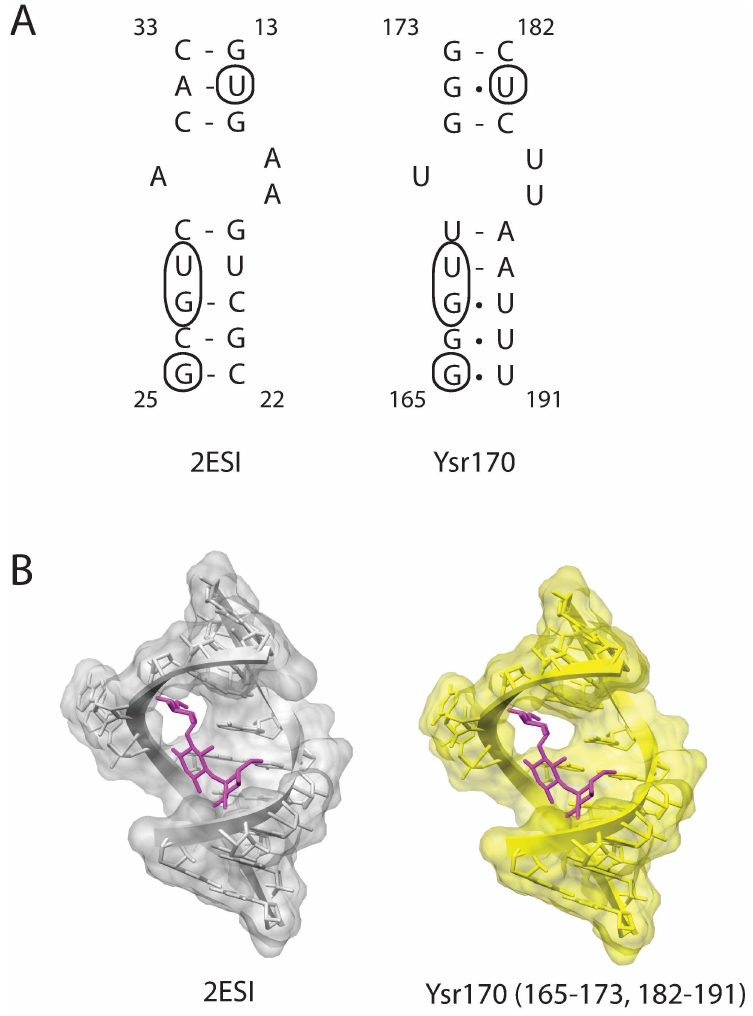
Fig 7. Structural modeling of Ysr170 binding to gentamycin. (A) The Ysr170 nucleotide regionthat binds to gentamycin, as determined by SHAPE analysis, is comparedto the sequenceof a structurally homologous regionfrom 16S rRNA (2ESI). The circled nucleotides are identicalbetweenthe 16S rRNA and Ysr170 sequences. (B) Modeledstructures of gentamycin (purple) interaction with the 2ESI sequenceand the Ysr170 bindingsite are